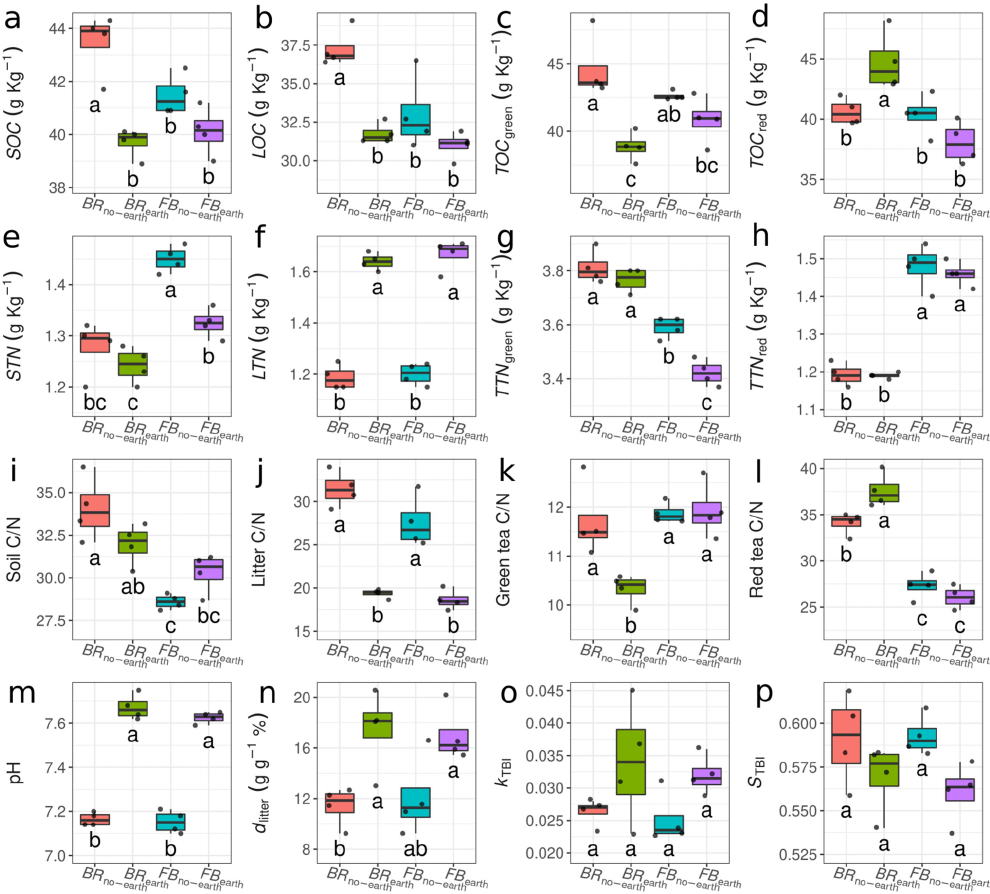
Figure 2. Boxplots of soil chemico-physical parameters in soil and litter under different treatments, consisting of broccoli with earthworms ( BR earth ), broccoli without earthworms ( BR no-earth ), faba bean with earthworms ( FB earth ), and faba bean without earthworms ( FB no-earth ). ( a ) Soil organic carbon ( SOC ); ( b ) litter organic carbon ( LOC ); ( c ) organic carbon in green tea bags ( TOC green ); ( d ) organic carbon in red tea bags ( TOC red ); ( e ) soil total nitrogen ( STN ); ( f ) litter total nitrogen ( LTN ); ( g ) total nitrogen in green tea bags ( TTN green ); ( h ) total nitrogen in red tea bags ( TTN red ); ( i ) soil carbon to nitrogen ratio (Soil C/N); ( j ) litter carbon to nitrogen ratio (Litter C/N); ( k ) carbon to nitrogen ratio in green tea bags (Green tea C/N); ( l ) carbon to nitrogen ratio in red tea bags (Red tea C/N); ( m ) soil pH (pH); ( n ) percentage of litter decomposed ( d litter ); ( o ) decomposition constant of tea bags ( k TBI ); ( p ) stabilization factor of tea bags ( S TBI ). Different letters indicate significant differences after two-way ANOVA followed by Tukey’s HSD test.